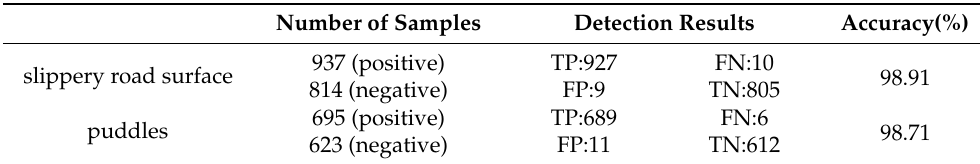
Table 1. The slippery road surface and puddles detection statistical results. Number of Samples Detection Results Accuracy(%) slippery road